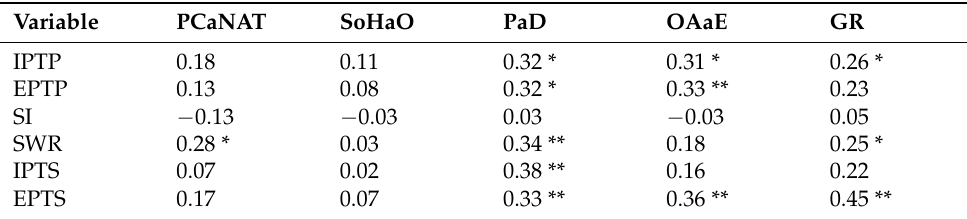
Table 4. R-Pearson Correaltions between Study Variables in the Subsample of Boys ( n = 63). Variable PCaNAT